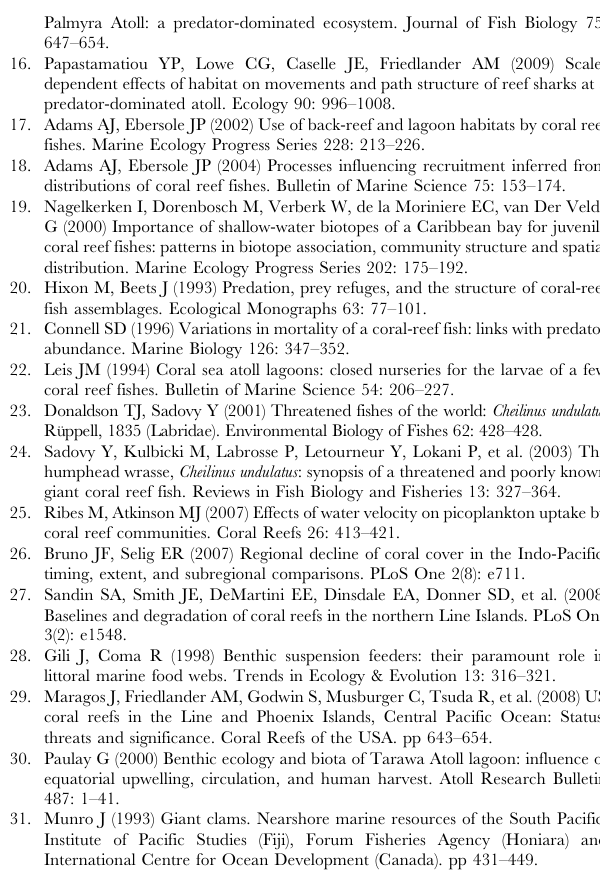
Table S1 List of fish species observed in the lagoon at Millennium Atoll during the survey period April 16th–24th, 2009 showing the measure of abundance, where: DO= Dominant, AB = Abundant, CO= Common, OC= Occasional, and RA =